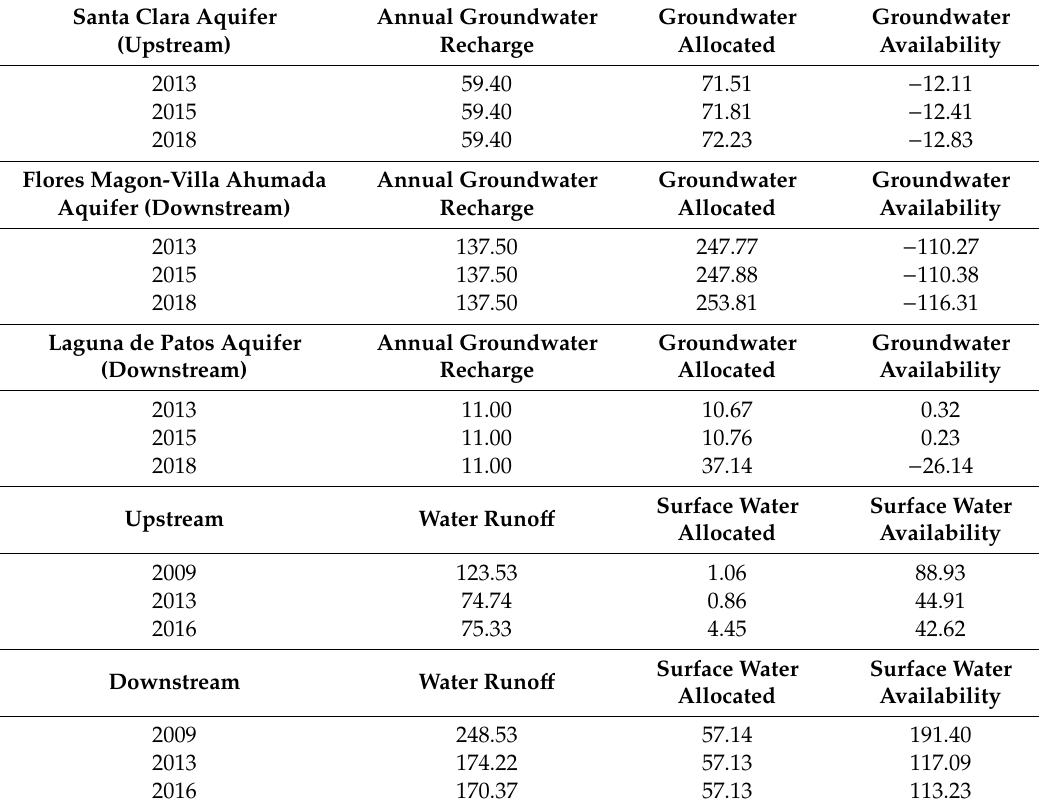
Table 2. Summary of the water sources in the watershed according to information published in the Mexican O ffi cial Journal of the Federation [39,63–67]. Figures are given in cubic meters per year.